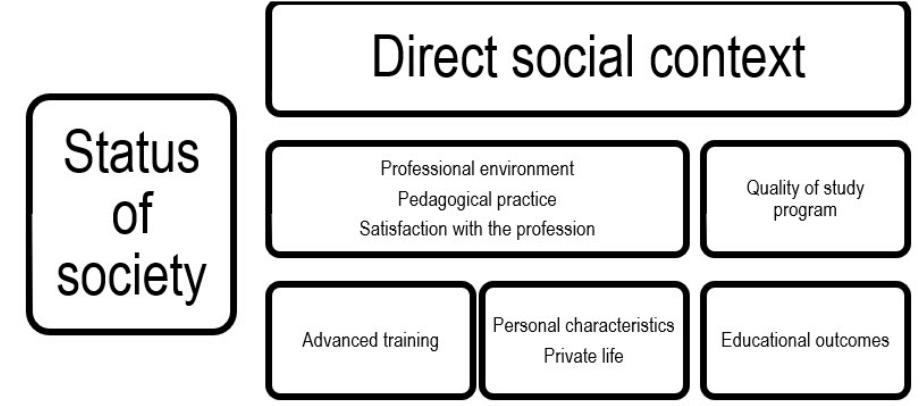
Figure 1. Factors influencing the professional performance of